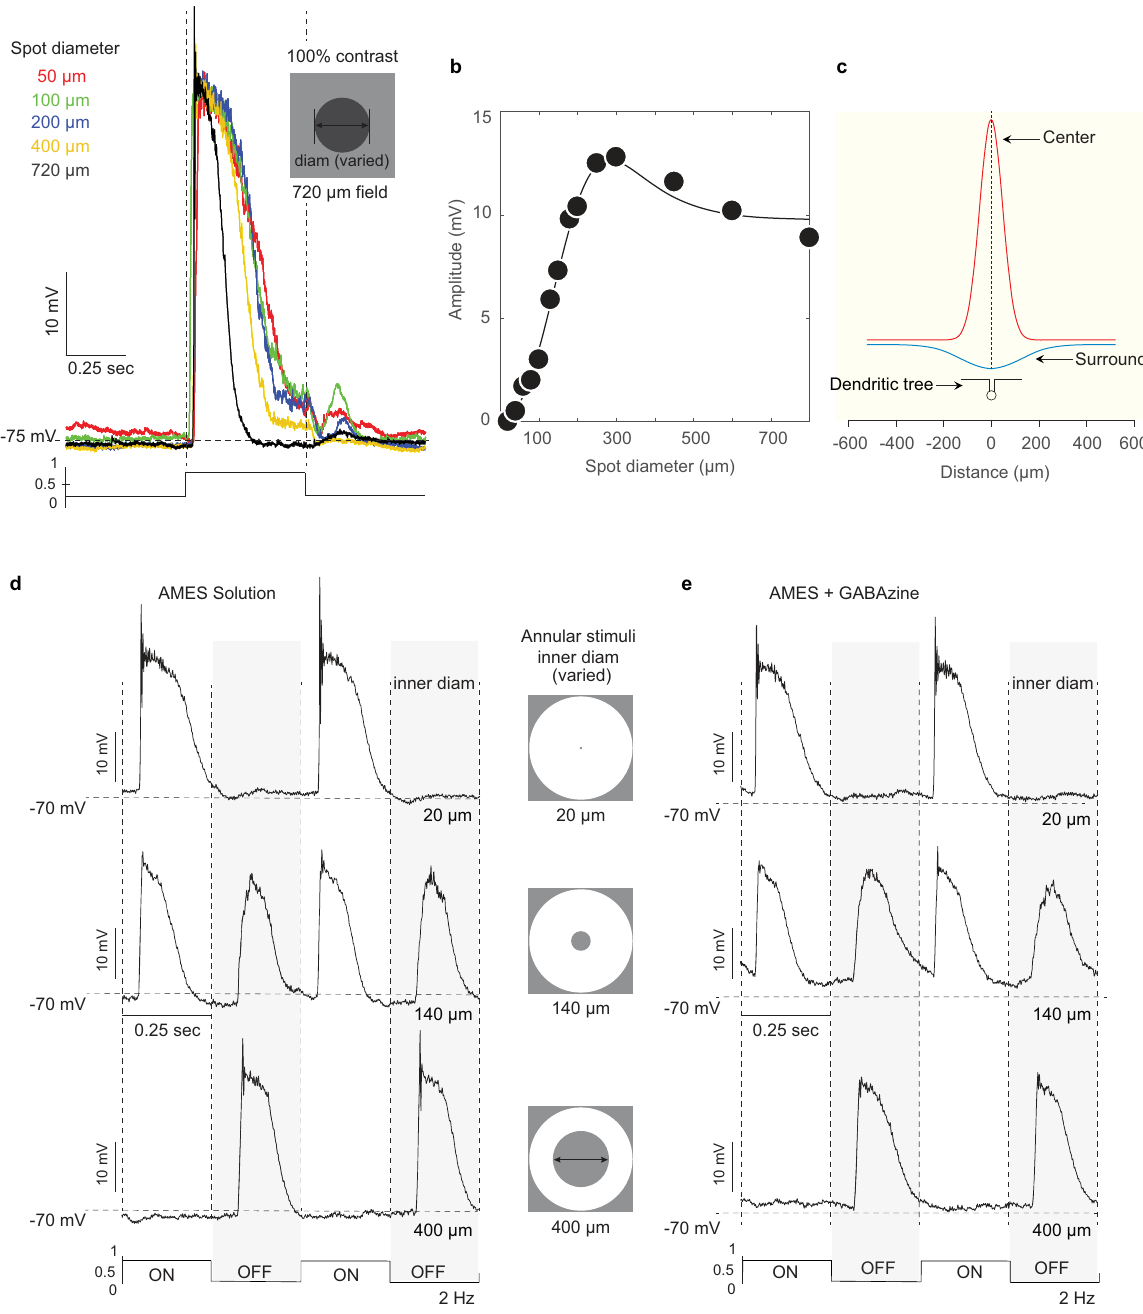
Fig. 7 Macaque starburst amacrine cells show center-surround receptive- fi eld structure that is insensitive to GABAa receptor antagonists. a Starburst whole-cell current-clamp recording (cell imaged in Supplementary Fig. 5e) shows a resting membrane potential ~75 mV on a high photopic background (~ 10 5 photoisomerizations/cone/sec) and large amplitude depolarizing response (~40 mV) to 0.5 s, 100% contrast, square wave pulse stimulus. With increasing spot diameter (inset at top; 50 – 720 µ m diameter; color coded) the response becomes more transient (black trace, 720 µ m diam spot) and the sustained response component is lost. A characteristic feature of the starburst response to this stimulus is a large, spike-like transient that appears as the stimulus is enlarged to fi ll the receptive- fi eld center. b , c Starburst spatial tuning (100% sinusoidal contrast modulation of spots of varied diameter at 2 Hz), fi t with a center-surround Difference-of-Gaussians receptive- fi eld model (line fi t to data; n = 27 cells; center diam, 208 ± 76; surround diam, 360 ± 156); 2D pro fi le of model fi t is shown in c ; small icon shows starburst soma and dendritic tree at same scale as model. d Surround response isolated by annular stimuli; increasing the inner diameter of the annulus from 20 to 400 µ m (icons at center; top to bottom panels; 2 Hz square wave modulation) eliminates the ON-center depolarization (top panel) and isolates a pure OFF-surround depolarization (bottom panel). e Surround OFF depolarization is not eliminated by bath application of GABAa receptor antagonist (SR 95331(GABAzine); 10 µ M; n = 4; 8 ± 3%